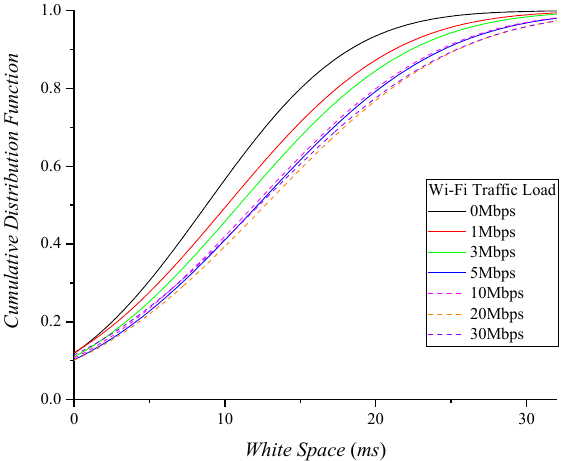
Figure 7. ECC white space with various Wi − Fi traffic loads.